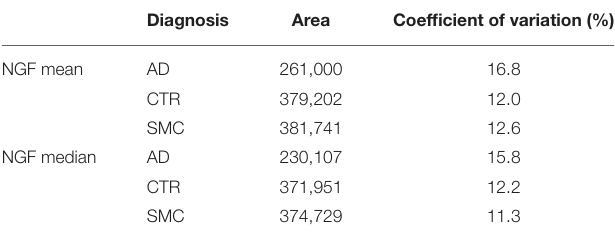
FIGURE 4 | (A) , by standardized Tau (B) , by standardized pTau (C) , and proNGF measures. For each panel, the predicted logistic scores are plotted on the left (AD subjects in red, SMC + control subjects in blue), while the model performances are shown on the right. The two ROC curves are compared by a one-sided Z -test (AUC2 > AUC1).